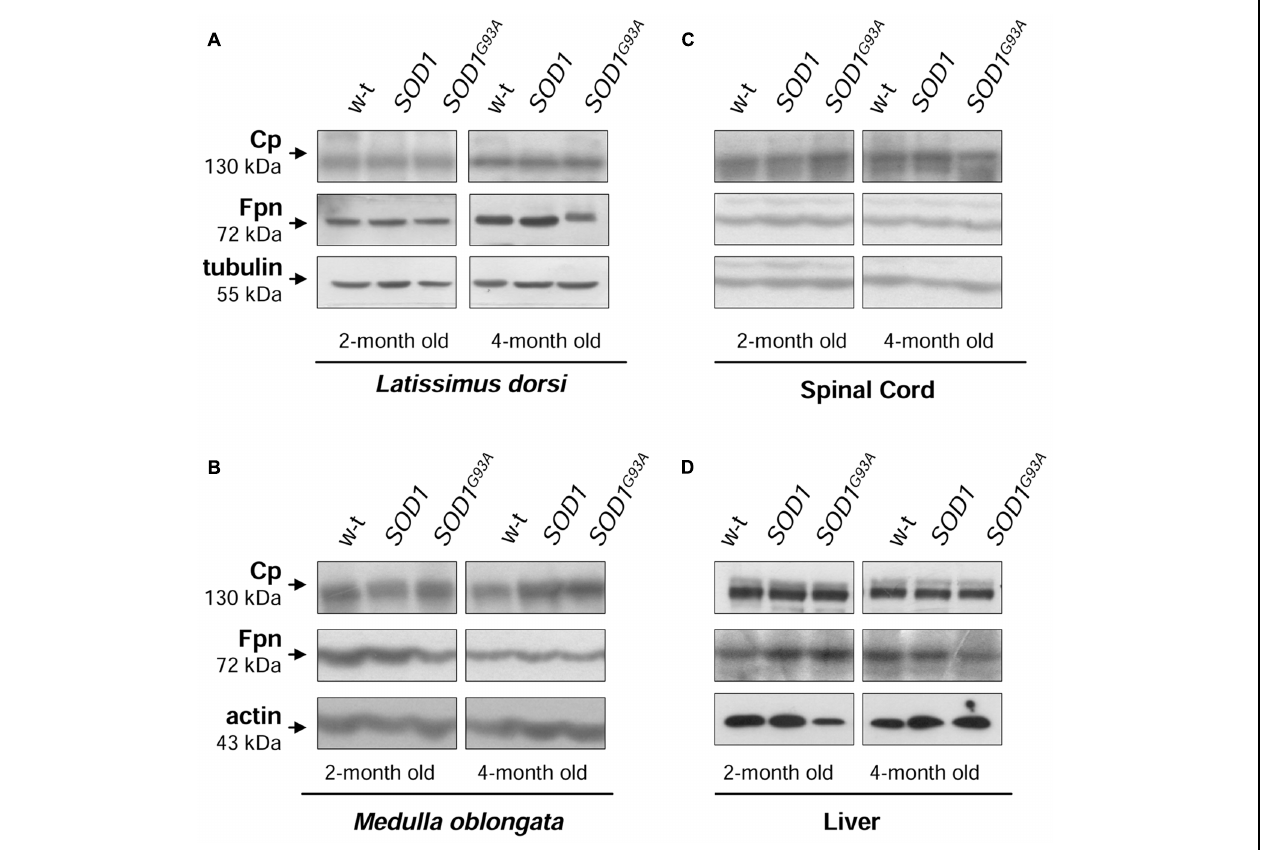
FIGURE 7 | Analysis of Cp and Fpn protein levels in tissues of experimental mice. Western blot analysis of Cp and Fpn protein levels in the Latissimus dorsi muscle (A) , neuronal tissues (B,C) , and liver (D) membrane extracts Tubulin and actin were used as loading controls. Data are representative for three independent Western blot analyses performed using extracts from three mice of each experimental group). The intensity of the IRP1 bands (relative to the intensity of tubulin or actin bands) was quantified with a Molecular Imager using Quantity One software (Bio-Rad) and is shown in arbitrary units to present proteins levels